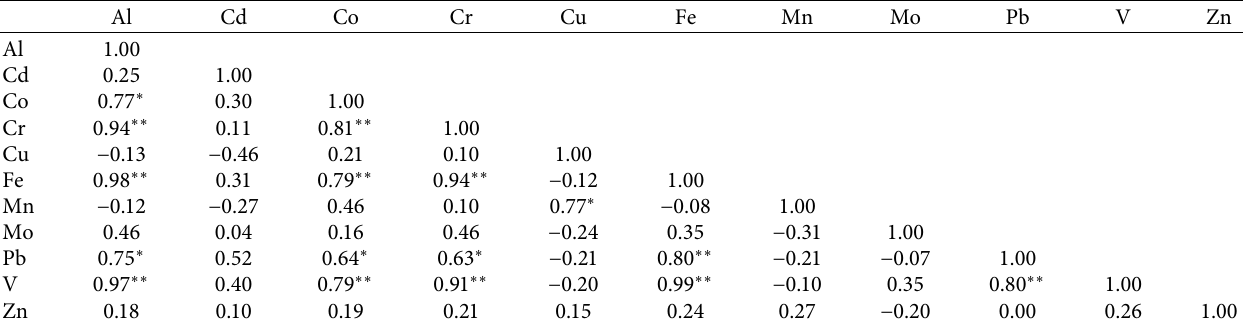
Table 5: Pearson’s correlation matrix of heavy metals elements in the studied plant species.